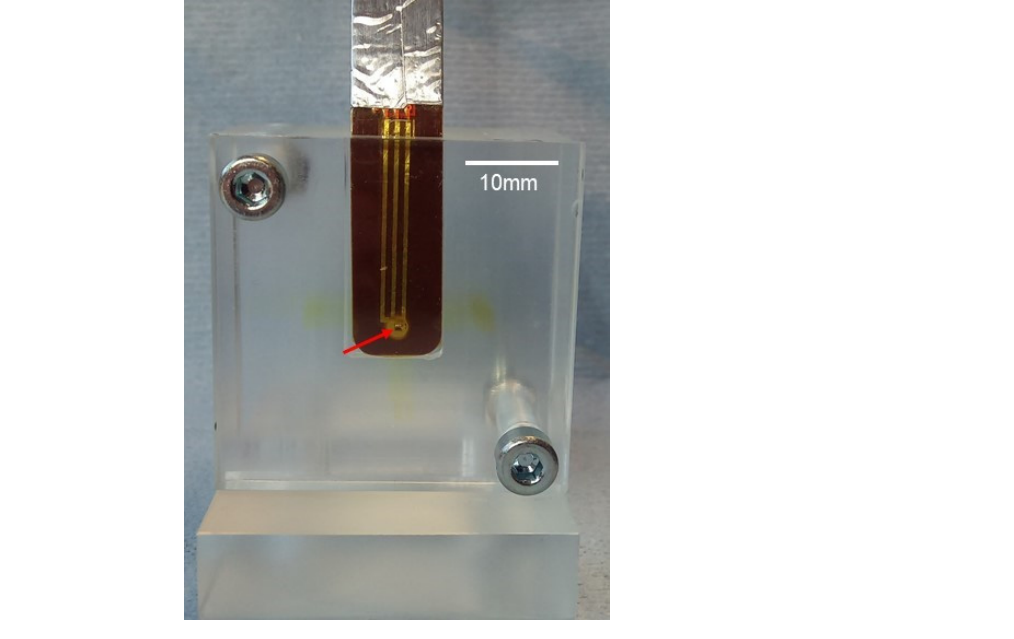
Figure 3. EPI-50 silicon strip detector embedded in a PMMA phantom in face-on view. The arrow indicates the approximate position of the sensitive area. The brownish staining in the PMMA was caused by a short exposure of the phantom to the X-ray beam.